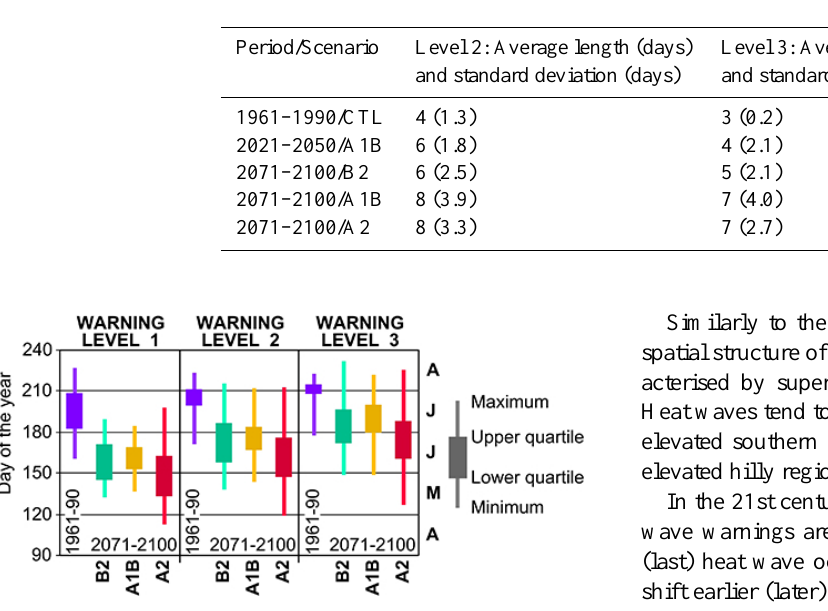
Table 2. Simulated lengths of heat waves corresponding to warning levels 2 and 3 within HHWS in Hungary.